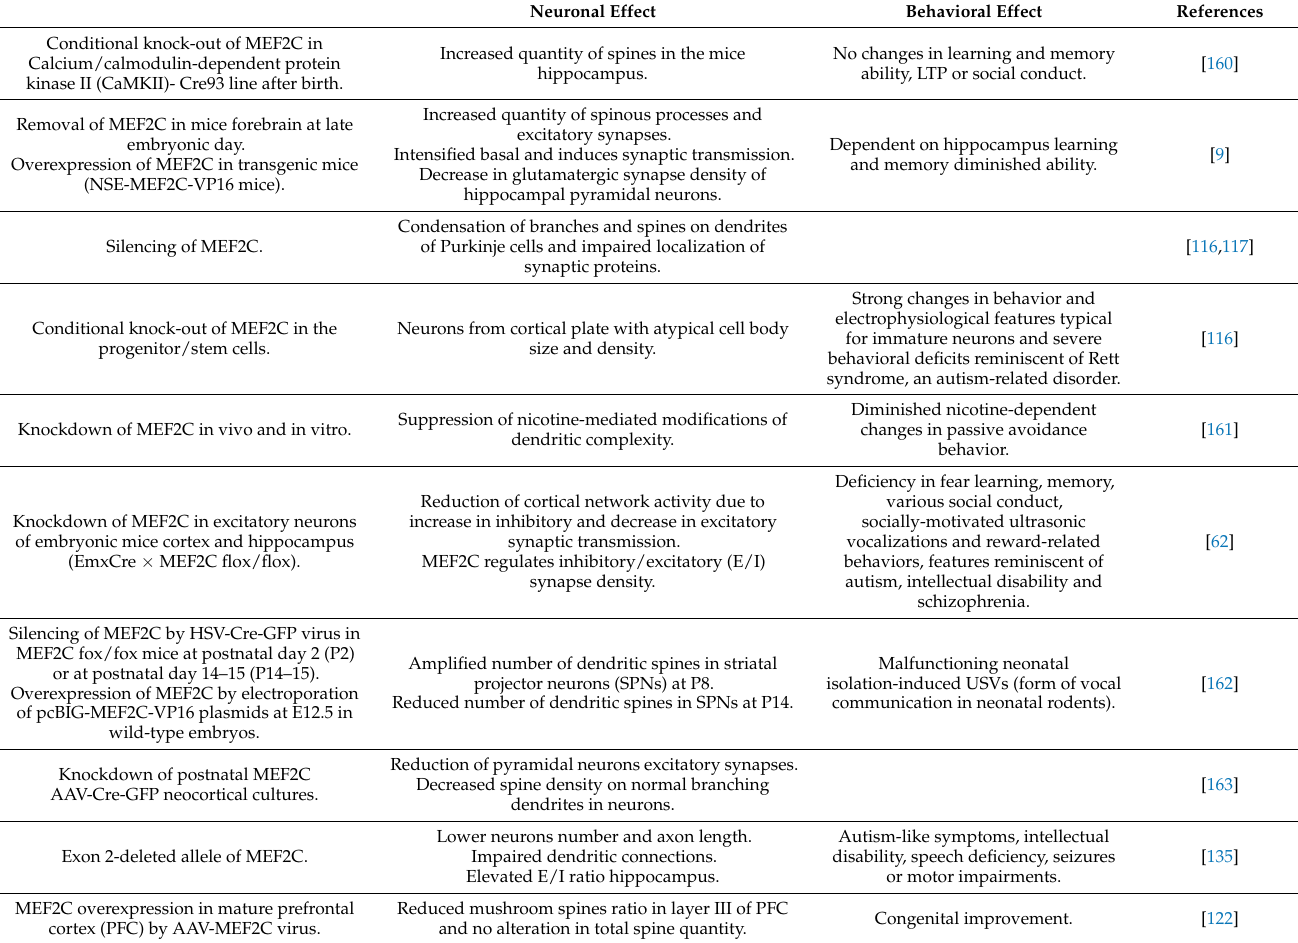
Table 2. Effect of MEF2C genetic manipulations on neuronal and behavioral